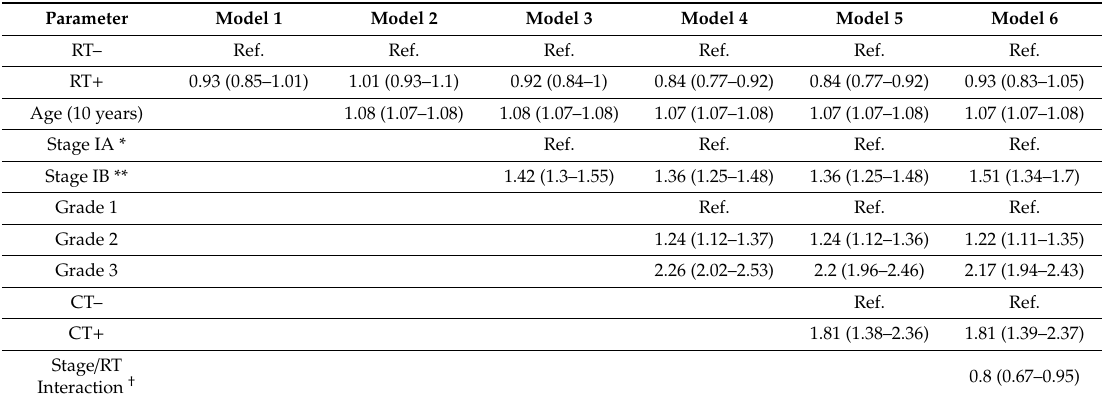
Table 2. Results of the relative survival